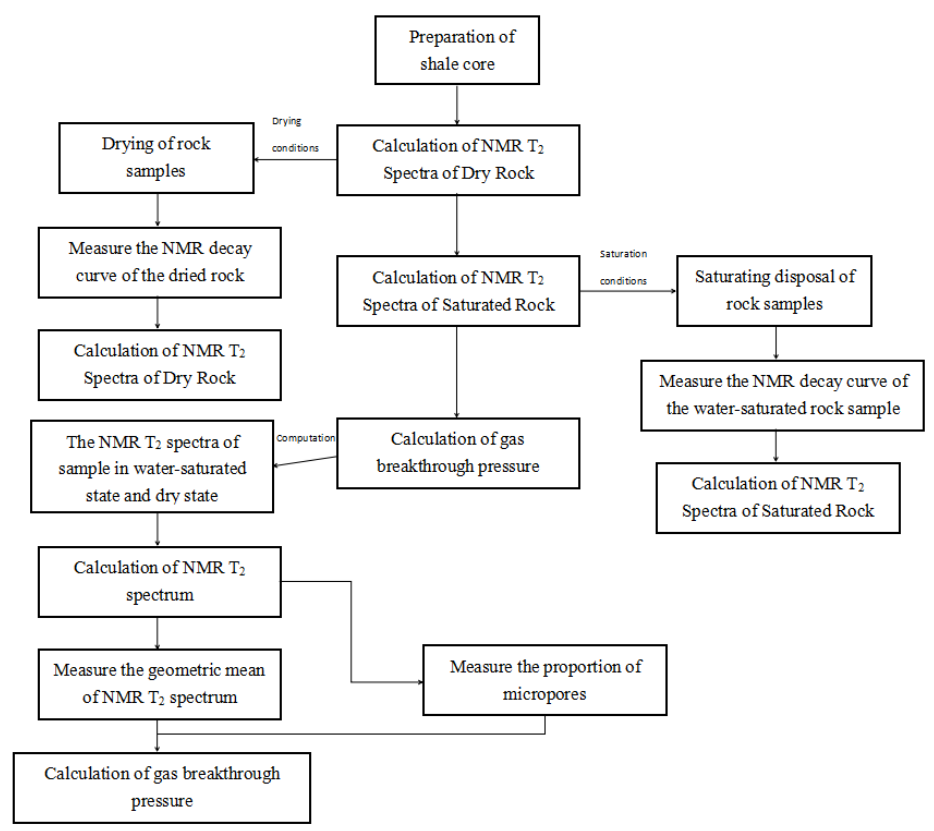
Figure 1. Flowchart of the calculation